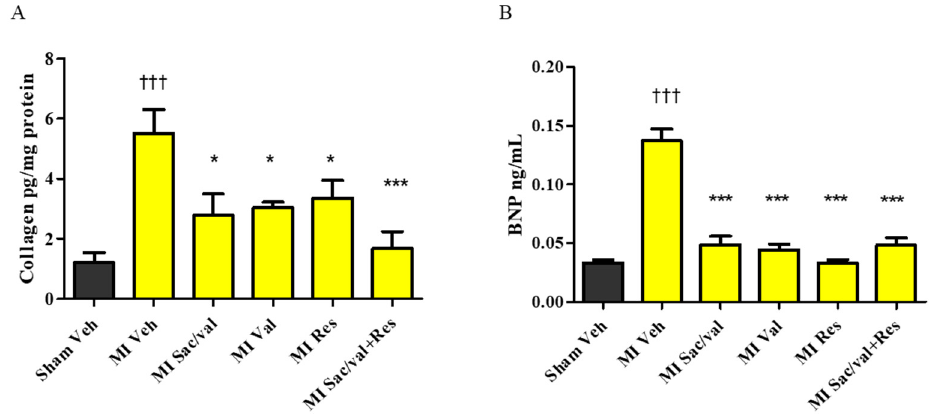
Figure 5. ( A ) Collagen; ( B ) brain natriuretic peptide (BNP). All values are expressed as mean ± SEM, n = 4–6. ††† p < 0.001 vs. Sham Veh; * p < 0.05, *** p < 0.001 vs. MI Veh. Veh—vehicle, Sac/Val—sacu-